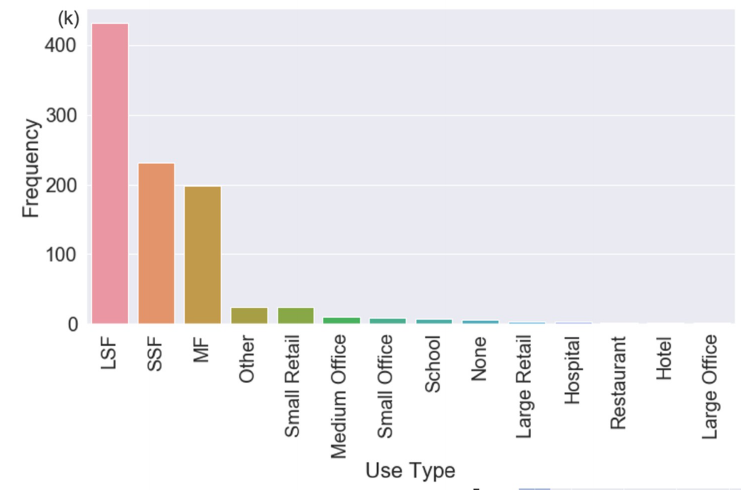
Figure 4. Building type distribution of all buildings in the city of LA. Atmosphere 2020 , 11 , x FOR PEER REVIEW